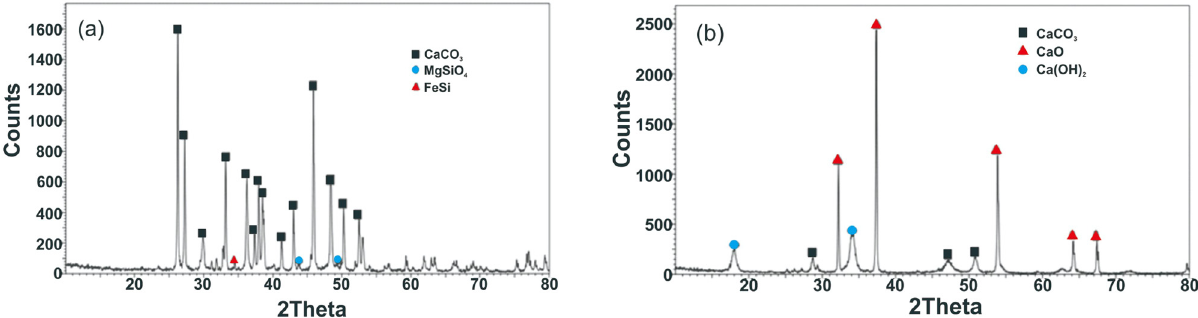
Figure 3: XRD of ( a ) coral and ( b ) heated coral at 900°C for 3 h.